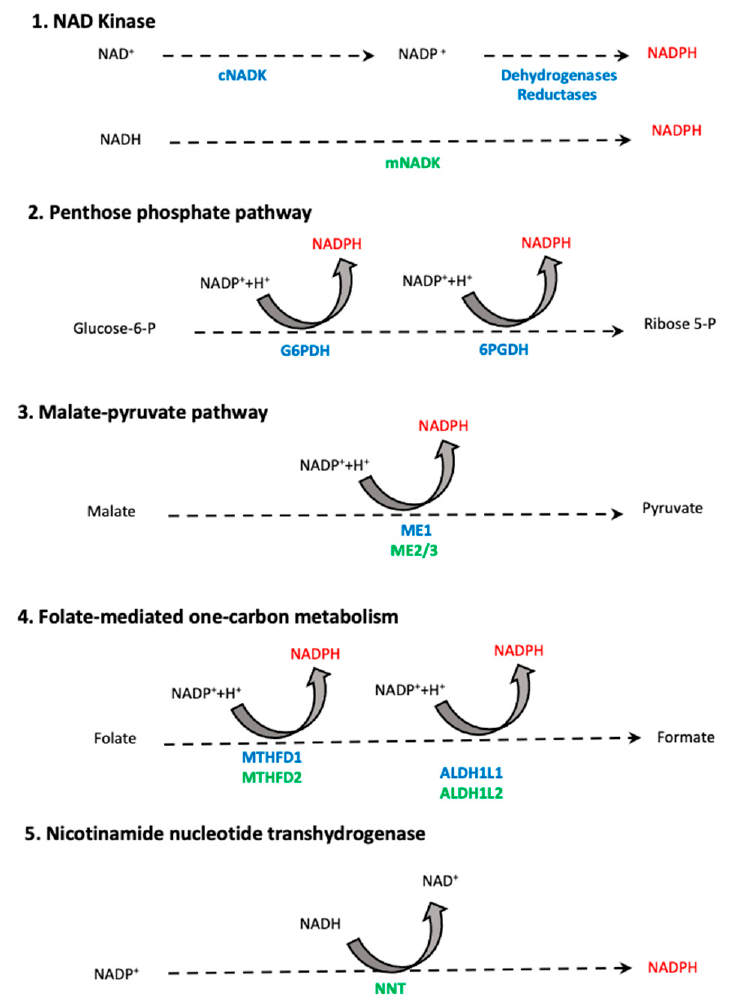
Figure 5. Schematic representation of cellular NADPH-producing pathways. NADPH is mainly pro- duced in glycolytic processes through the pentose phosphate pathway and during malate–pyruvate conversion. In addition, the complex cytosolic and mitochondrial folate-mediated one-carbon cycles provide NADPH. Lesser amounts of NADPH are provided by the direct phosphorylation of NAD + and NADH. In the mitochondria, the enzymatically catalyzed reduction of NADP + by NADH can provide local NADPH (reviewed in [5]). Dotted lines indicate multistep processes, cytosolic enzymes are marked in blue, mitochondrial enzymes are marked in green. cNADK: cytosolic nicotinamide adenine dinucleotide phosphate kinase, mNADK: mitochondrial nicotinamide adenine dinucleotide phosphate kinase, G6PDH: glucose-6-phosphate dehydrogenase, 6PGDH: 6-phosphogluconate dehy- drogenase, ME1: malic enzyme 1, ME2/3: malic enzyme 2/3, ALDH1L1: 10-formyltetrahydrofolate dehydrogenase 1, ALDH1L2: 10-formyltetrahydrofolate dehydrogenase 2, MTHFD1: methylenete- trahydrofolate dehydrogenase 1, MTHFD2: methylenetetrahydrofolate dehydrogenase 2, NNT: nicotinamide nucleotide transhydrogenase.